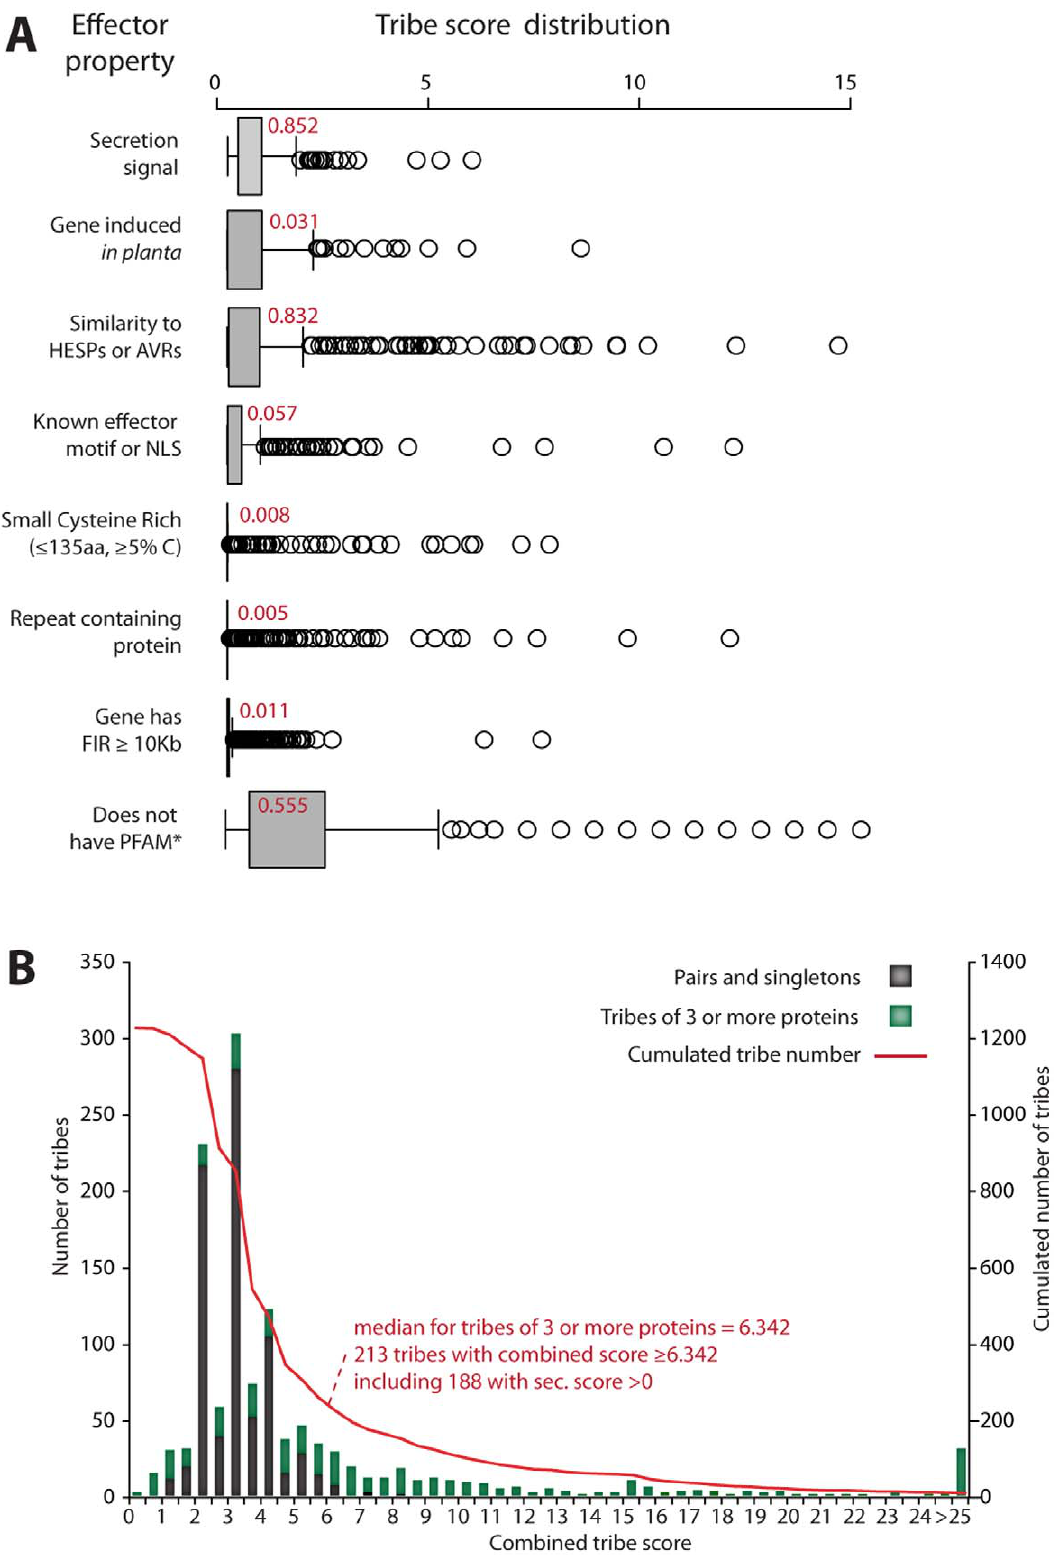
Figure 5. Distribution of scores for effector candidates in secretome tribes from M.larici-populina and P.graminis f. sp. tritici . (A) The distribution of scores (equivalent to -log of e-value) for individual effector properties among tribes given as a boxplot (same conventions as in Figures 2 and 3). The median value is indicated in red. (B) Distribution of combined scores (sum of scores for individual effector properties) among the 1222 tribes analyzed. A combined score threshold $ 6.342 (median value for tribes of 3 or members) and secretion signal (sec.) score . 0 was used to select 188 tribes for hierarchical clustering. *Five PFAM domains associated with pathogenicity and enriched in secretome tribes of rust fungi (Table 1) and PFAM-B domains were permitted. doi:10.1371/journal.pone.0029847.g005 PLoS ONE |